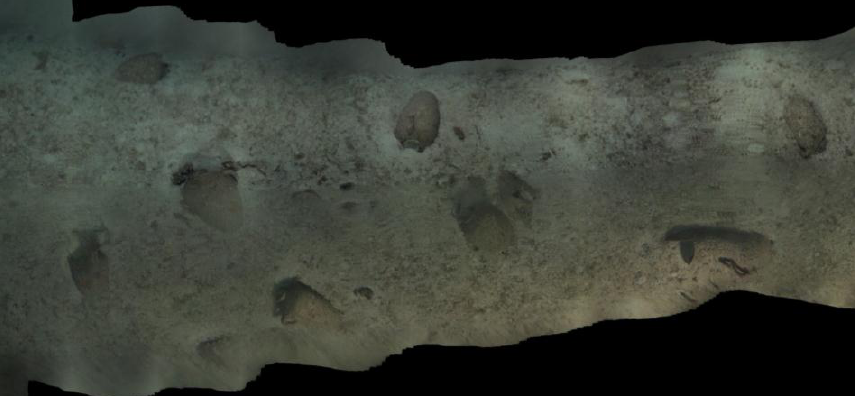
Figure 8. Partial orthophograph produced by the real-time visual odometry orientation. Some small imperfection are visible due to the orientation accuracy, however, the 3D model is visually appealing and acceptable to validate the